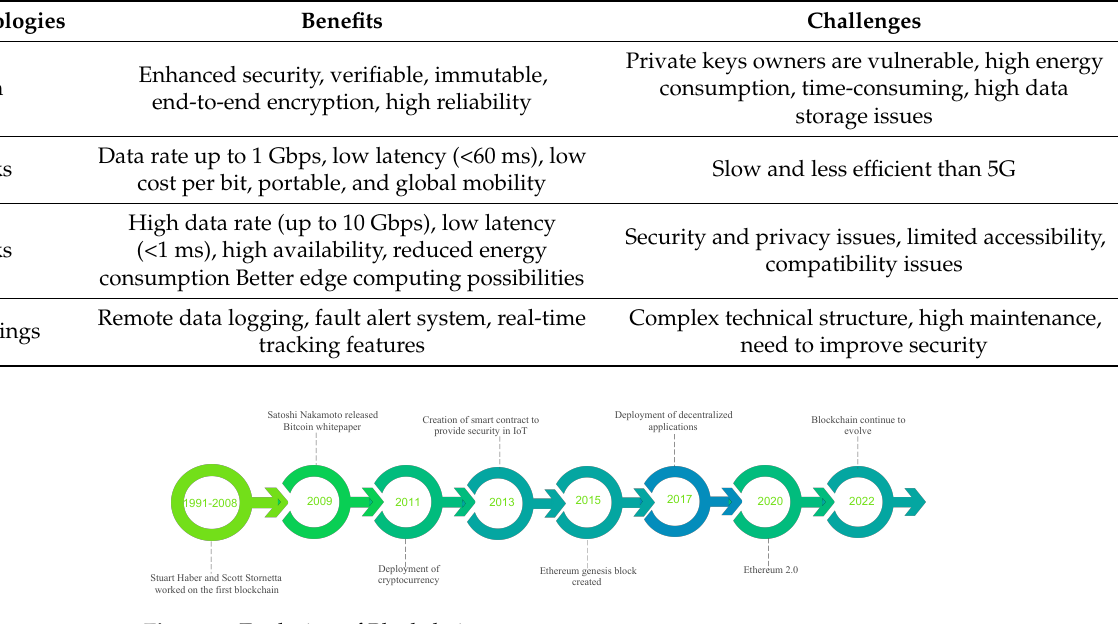
Figure 1. Evolution of Blockchain.